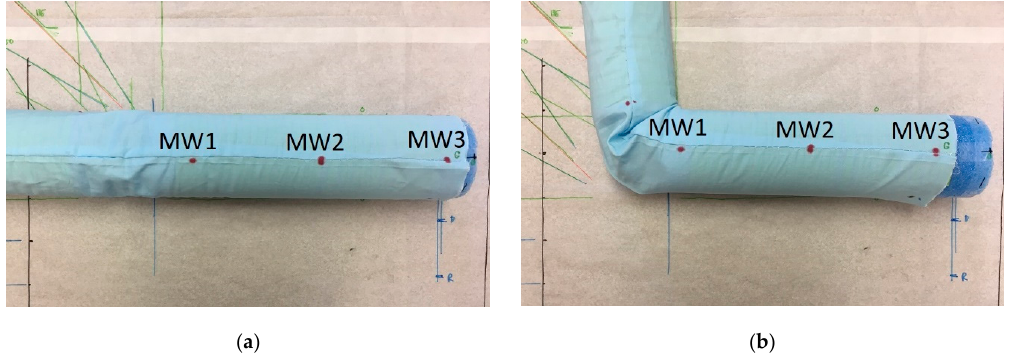
Figure 4. Experimental setup of arm with tight sleeve in ( a ) extension (at 0°) with no displacement and ( b ) after flexion ( θ f = 90°), showing the displacement of the sleeve caused by the fabric bunching up at the joint.